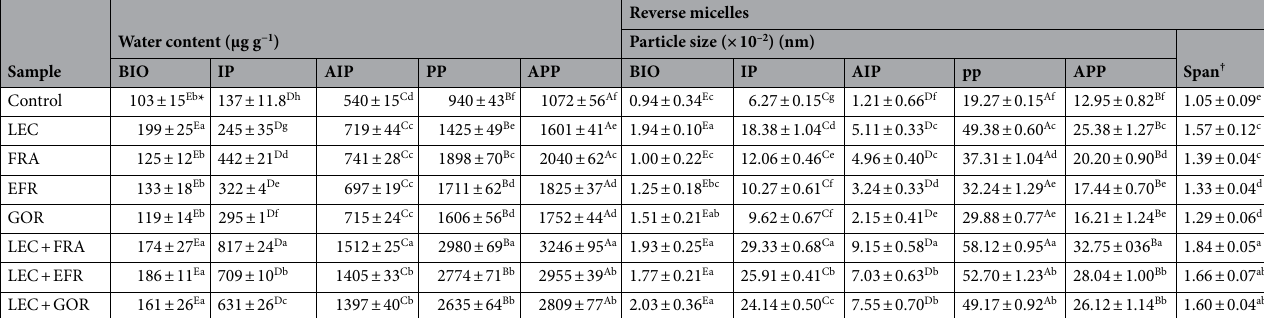
Table 2. Water content and reverse micelles size related to the stripped sunflower oil peroxidation (Control) containing lecithin (LEC), ferulic acid (FRA), ethyl ferulate (EFR), γ-oryzanol (GOR), and their combinations at 60 °C. *In each row and in each section, averages (± standard deviation) with different uppercase letters are significantly different ( P < 0.05). In each column, averages (± standard deviation) with different lowercase letters are significantly different ( P < 0.05). BIO at the beginning of the oxidation, IP at the induction period, AIP after the induction period, PP at the propagation period, APP after the propagation period, Span = [(Dv0.9-Dv0.1)/Dv0.5] (Dv: represent particle sizes larger than 10, 50, and 90% of the population), † the average spans of BIO, IP, AIP, PP, and